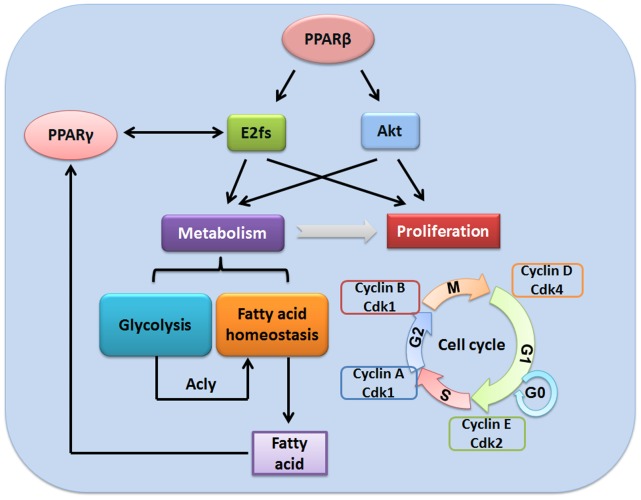
Summary for the role of PPARβ in regulating liver regeneration through E2f-regulated pathway.PPARβ up-regulates Akt- and E2fs, which control glycolysis, fatty acid homeostasis as well as cell proliferation in regenerating livers. In terms of metabolism, E2fs gene regulation facilitates glucose-stimulated insulin secretion and the breakdown of glucose through glycolysis. E2fs regulate lipid homeostasis through modulating PPARγ expression. Akt activates the key enzymes involved in fatty acid synthesis. Moreover, Acly enhances cholesterogenesis and lipogenesis that may lead to fat accumulation in regenerating liver where it is used to stimulate cell proliferation. The produced fatty acid activates PPARγ, which might regulate E2fs through a feedback loop. Consequently, these metabolic activities generate energy and intermediates for cell proliferation. In addition to their roles in cell metabolism, Akt also regulates cell cycle through Cyclin D/Cdk4 complex while E2fs modulate cell cycle regulation, DNA replication and repair, as well as checkpoint control.